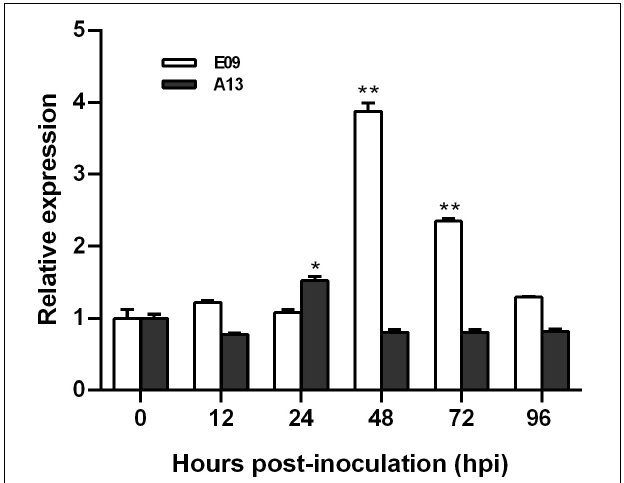
FIGURE 1 | Transcript profiles of TaGSL22 after inoculation with avirulent (E09) and virulent (A13) Bgt races. Relative gene quantification was calculated by the comparative (cid:49)(cid:49) CT method. Data were normalized to the expression level of the wheat elongation factor TaEF-1 α . * and ** indicate significant differences ( P < 0.05 and P < 0.01) from the mock-inoculated control at 0 hpi using Student’s t -test. Error bars represent SEM of three biological replicates.